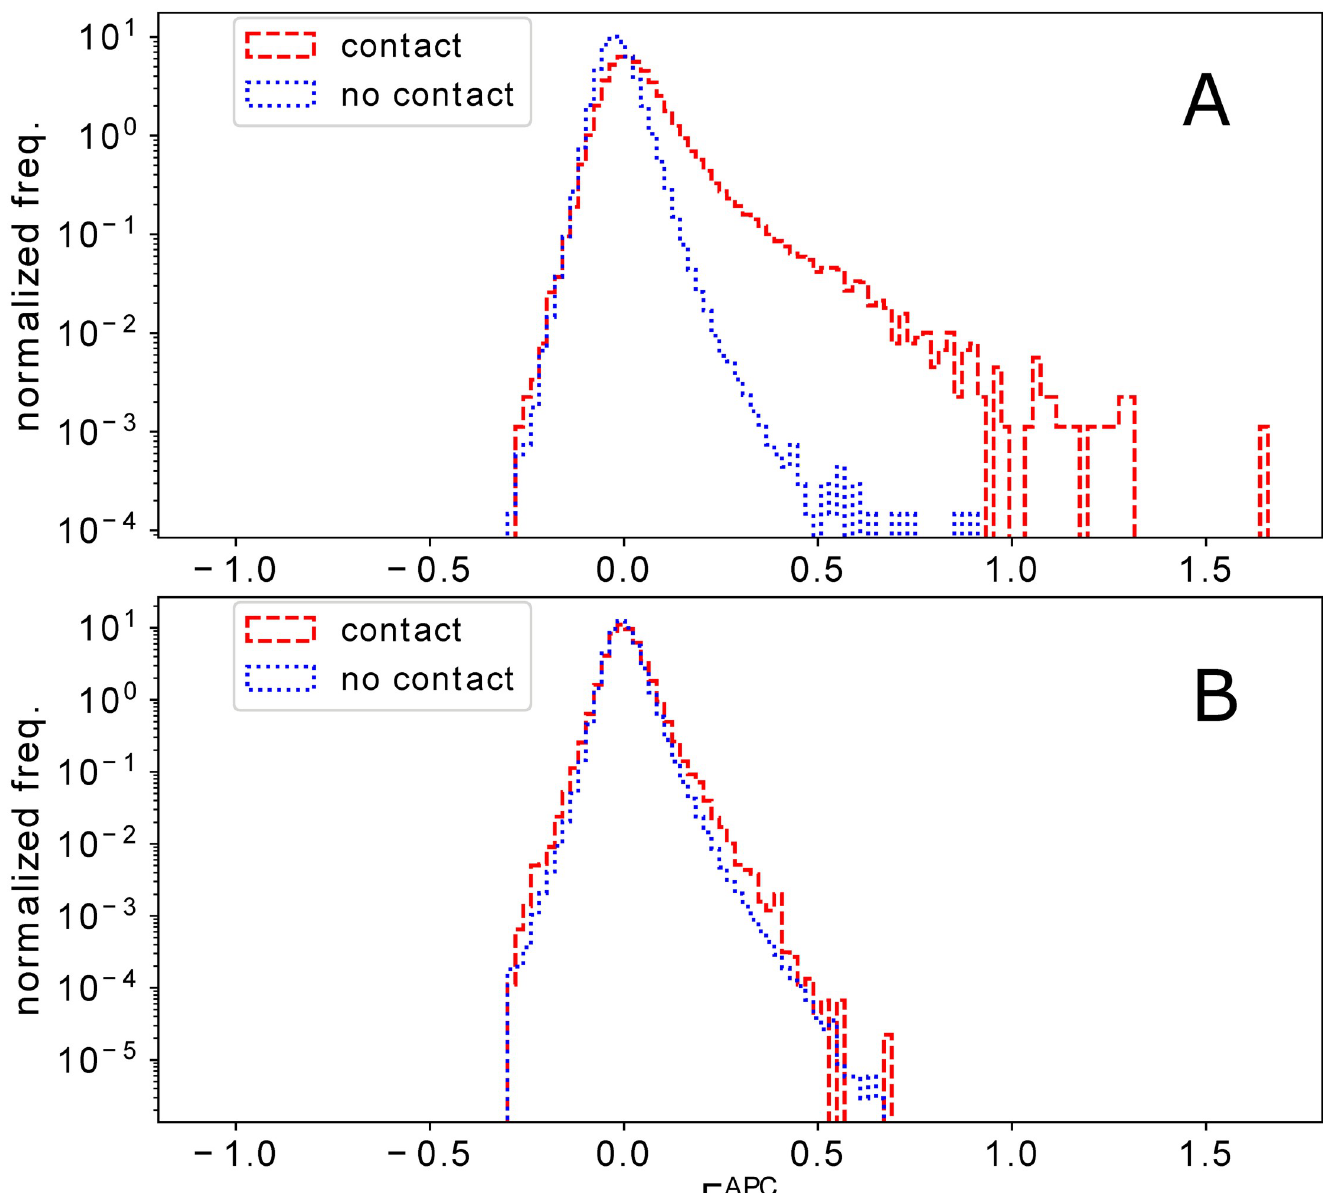
Fig 4. Histogram of DCA scores derived from natural sequence data (Panel A) and Null model II (Panel B) for residue-residue contacts and non-contacts. For the protein families in DS2, we show the histograms of DCA coupling scores (APC corrected Frobenius norm of couplings), separated for contacts and non-contacts (defined using the representative protein structures in Table B in S1 Text). Only pairs with linear separation | i − j | > 4 along the chain are taken into account.